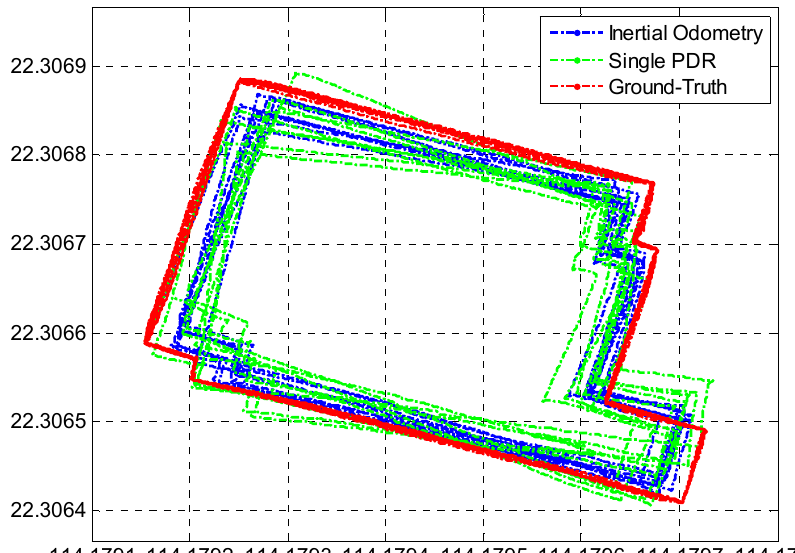
Figure 5. Estimated Trajectory of Inertial Odometry.